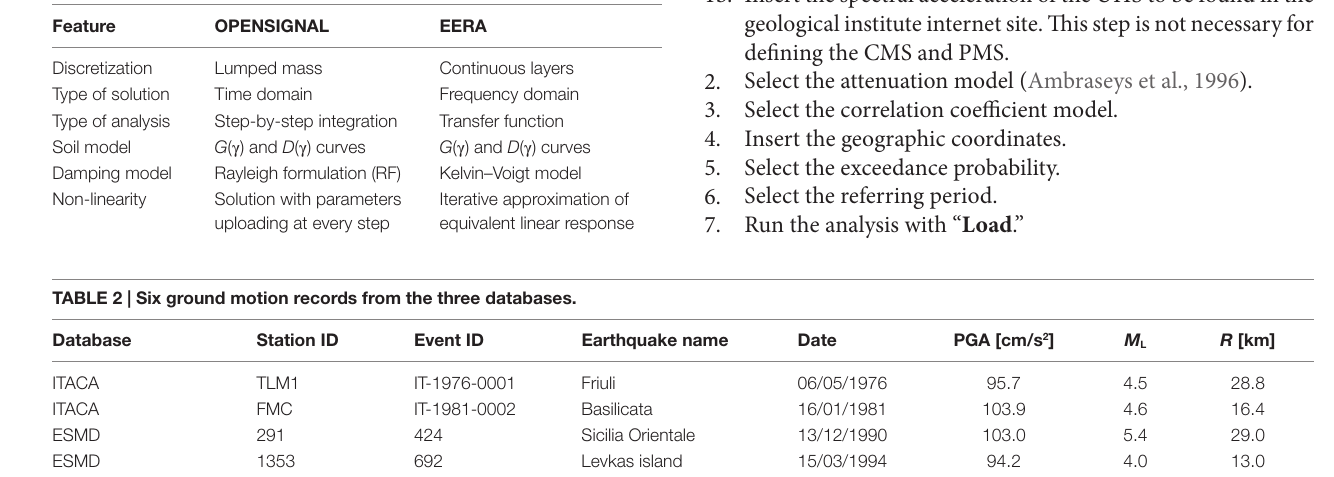
TaBle 1 | OPensignal soil response analysis vs. eera.